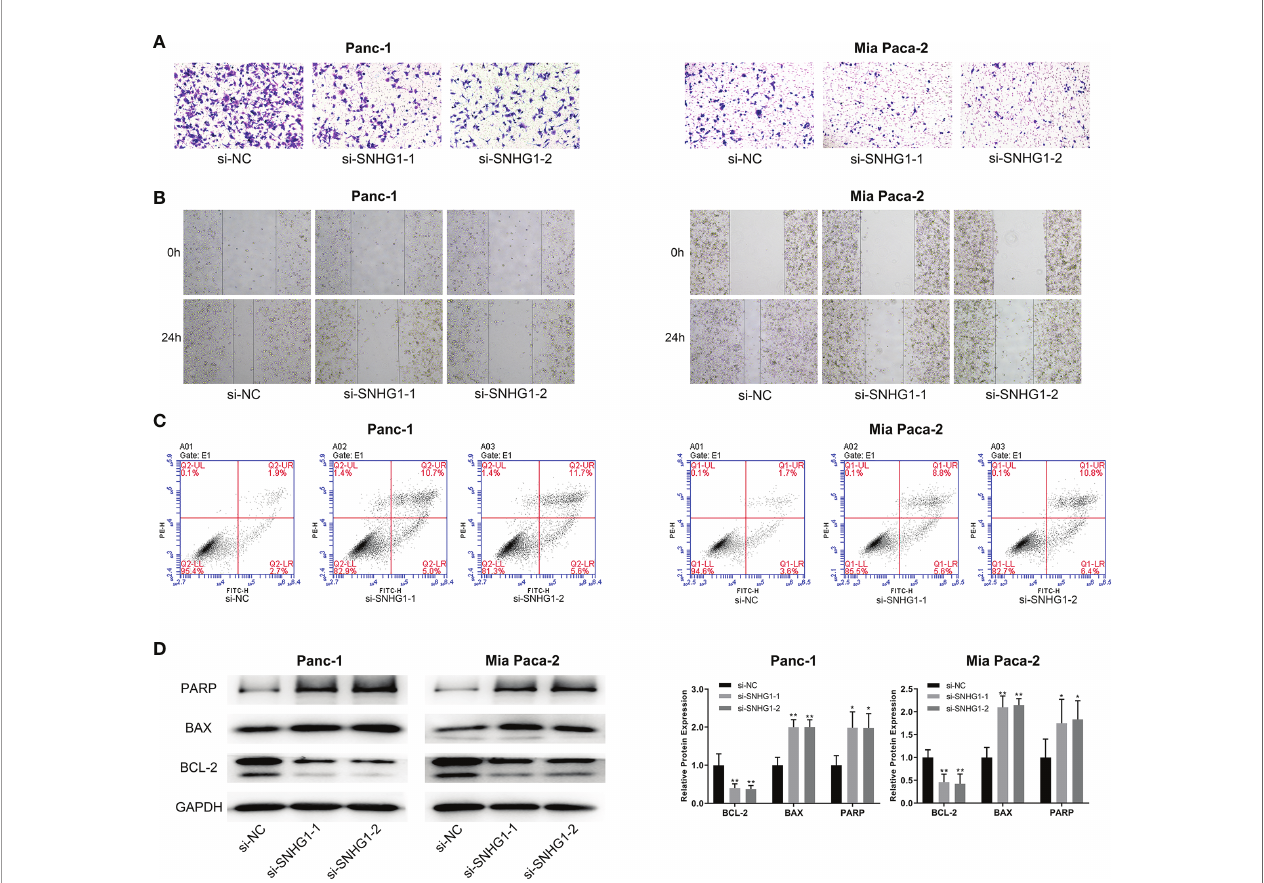
FIGURE 2 | Downregulation of SNHG1 suppresses PC cell invasion and promotes apoptosis. (A, B) Scratch wound-healing assay and Transwell migration assay showed impaired migration and invasion ability in Panc-1 and Mia paca-2 cells after SNHG1 silencing. (C) Increased apoptosis after SNHG1 silencing was shown by fl ow cytometry. (D) WB of apoptosis-related proteins. *p < 0.05, **p <